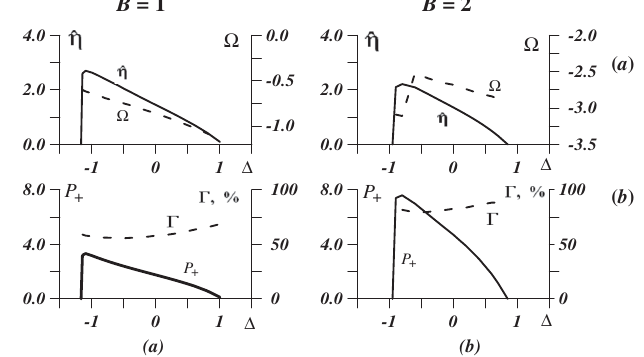
FIG. 4. Dependence of the steady-state regime characteristics on the electron synchronism detuning parameter (cid:2) for the normalized gap B ¼ 1 (left), B ¼ 2 (right) at the same parame- ters as in Fig. 2: (a) normalized efficiency ^ (cid:13) and the electron frequency shift (cid:3) ; (b) normalized output power P and its a ratio to the total power radiated from the beam (cid:4)